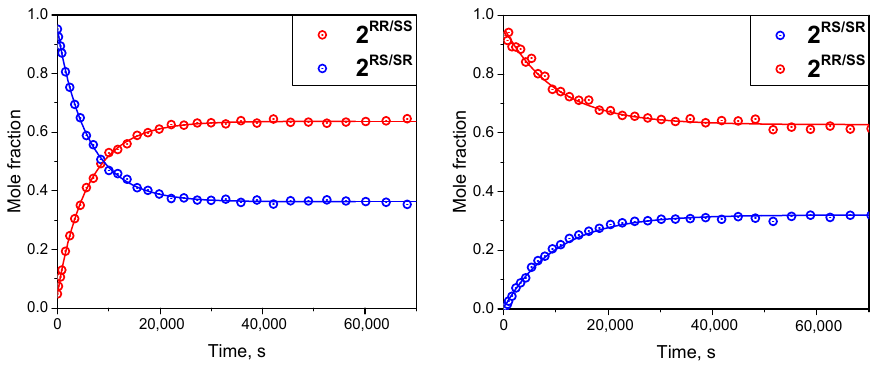
Figure 6. Kinetic curves for the epimerization reaction of alkoxyamines 2 RS/SR and 2 RR/SS . Table 1. Rate constants ( × 10 − 5 s − 1 ) for the reactions of alkoxyamines ( ≈ 0.02 mol / L) with BME (2 mol / L), PhSH (2 mol / L) and TEMPO (3 eqv. a ) in toluene-d 8 at 347 K by NMR. None None TEMPO